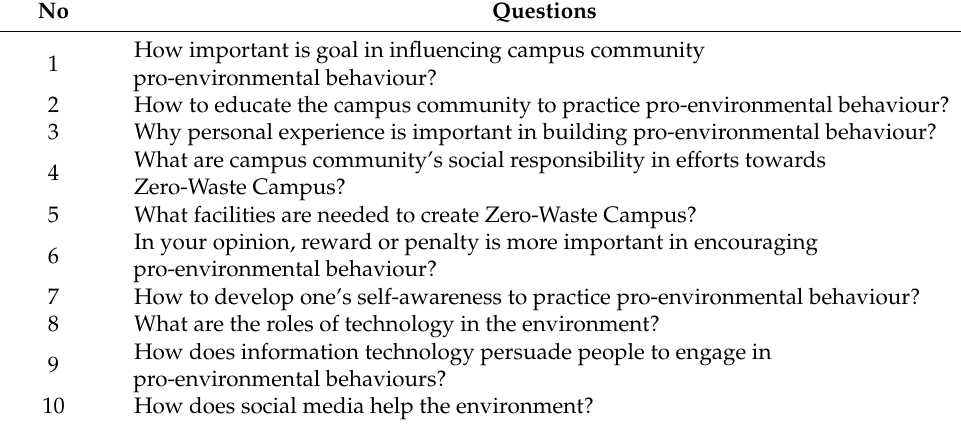
Table 5. In-Depth Interviews